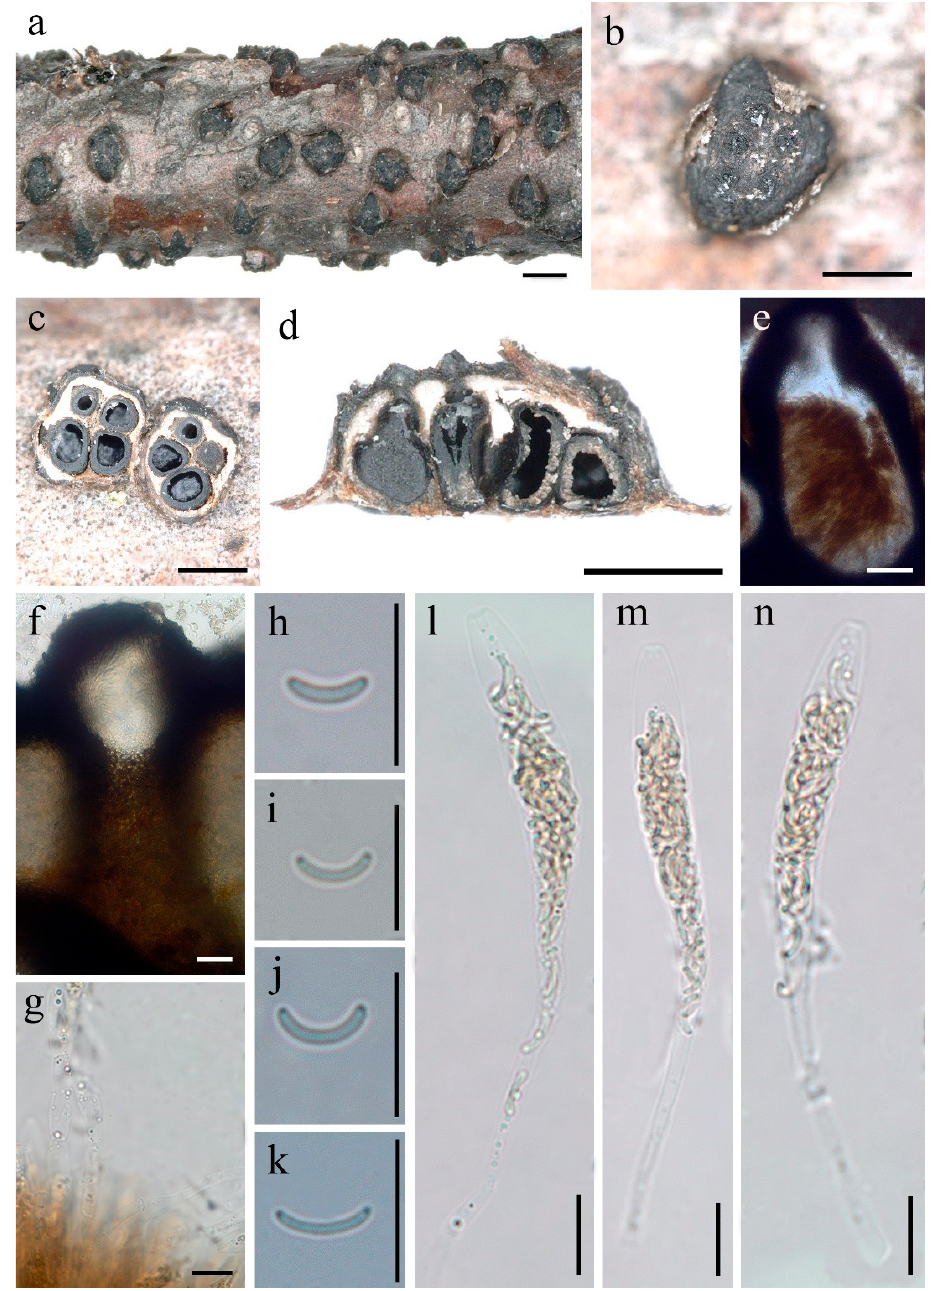
Figure 3. Diatrype larissae (FCATAS 2723, Holotype). ( a – b ) Stromata on substrate; ( c ) cross section of a stroma; ( d – e ) vertical section through stroma showing ostioles and perithecia; ( f ) ostiolar canal; ( g ) paraphyses in water; ( h – k ) ascospore in water; ( l – n ) ascus in water; scale bars (( a ) = 1 mm; ( b – d ) = 500 µ m; ( e ) = 20 µ m; ( f – n ) = 10 µ